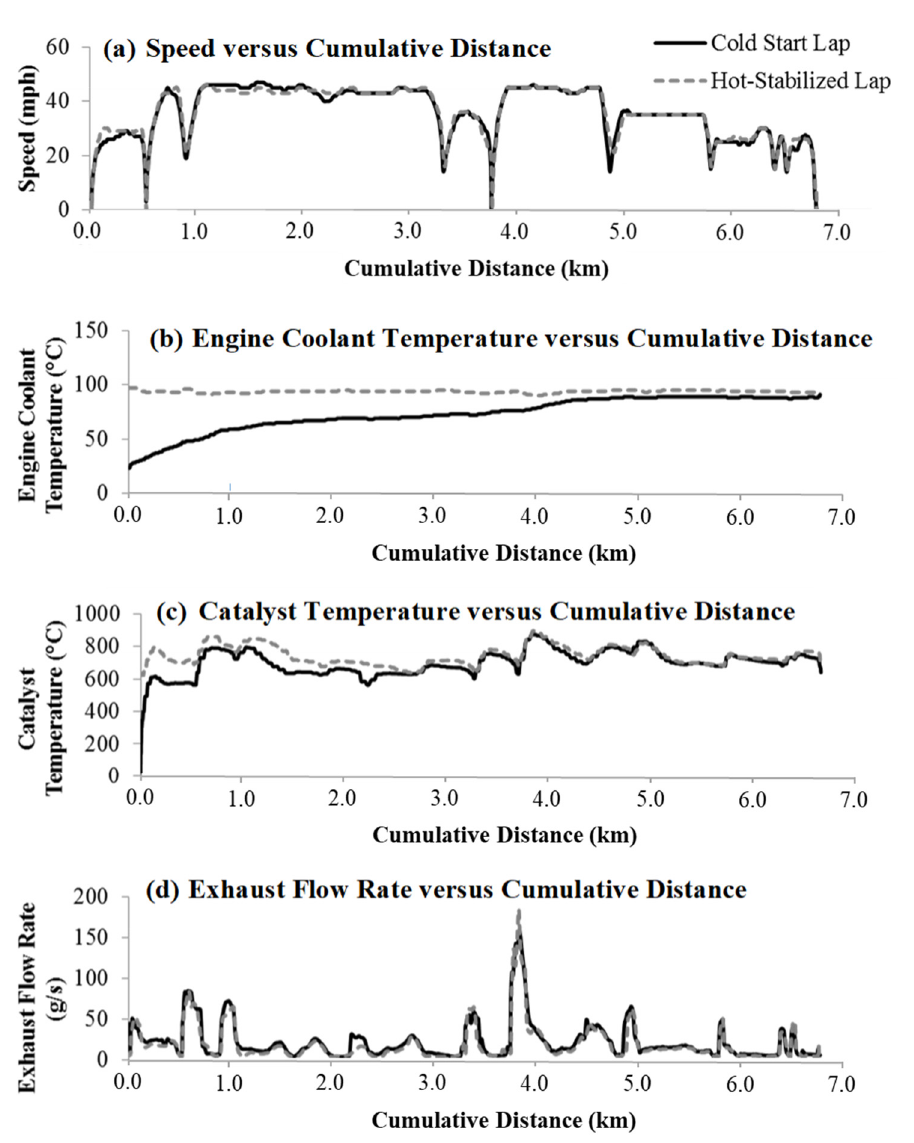
Figure 6. Speed, engine coolant temperature, catalyst temperature, and exhaust flow rate versus cumulative distance during driving cold start measurement for a 2015 Ford Fusion.